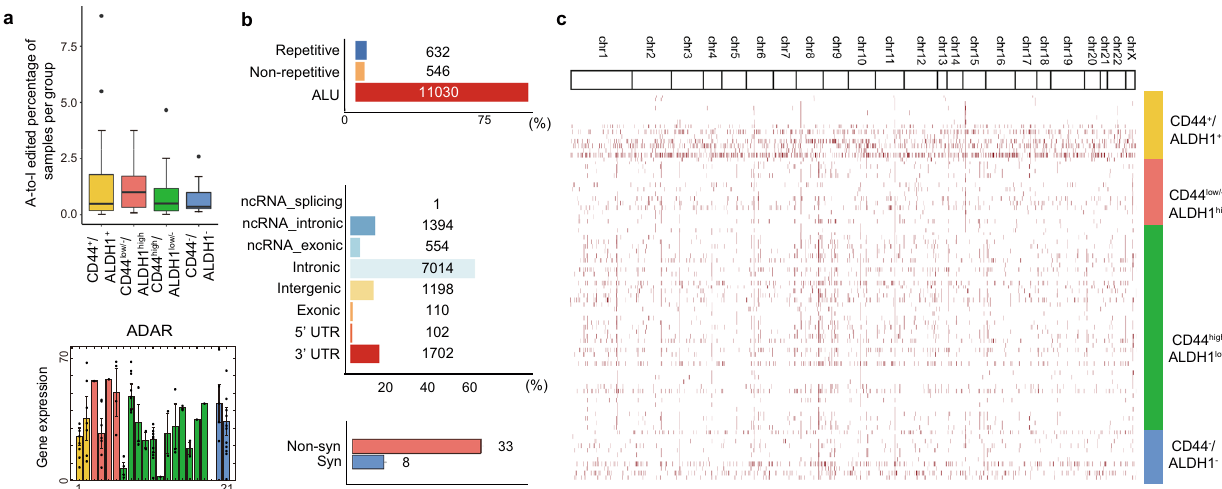
Fig. 5 Spatial A-to-I editome marks characteristic features for different staining groups. Source data are provided as a Source Data fi le. a Percentage of A-to-I-edited samples per staining group (top) ( n = 106 biologically independent samples (ROI)). Interquartile range (IQR) of boxplot is between Q1 and Q3 and centre line indicates median value. Whiskers of boxplot is extended to the maxima and minima. Maxima is Q3 + 1.5*IQR and minima is Q1 − 1.5*IQR. Bar graphs of ADAR gene expression according to the spatial groups (bottom). Bar plot indicates mean value and error bar indicates standard deviation. b Portions of A-to-I-edited regions in the genome (top). Pro fi les of editing in the non-repetitive regions, excluding upstream and downstream regions (middle). Portions of non-synonymous (Non-syn) and synonymous (Syn) editing events among the exonic-edited regions (bottom). c A-to-I editome landscape of different microniche groups.